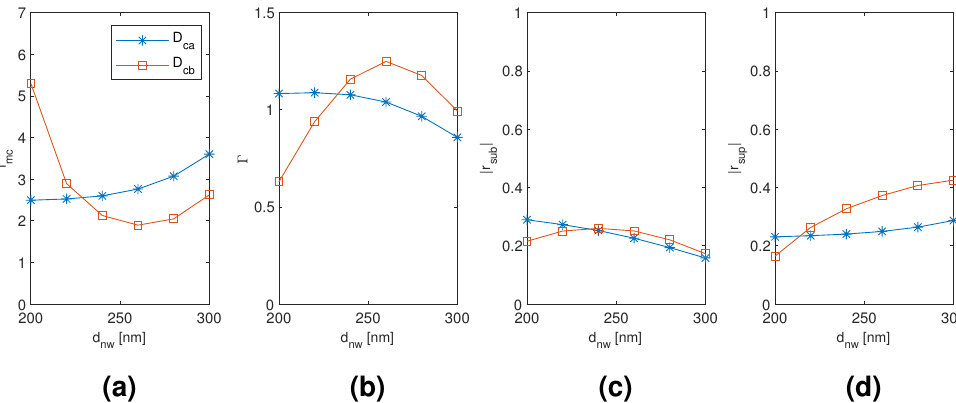
Figure 12. The results for the coated dimer D ca and D cb mode as a function of the diameter of the nanowires with the coating thickness and the separation of the nanowires corresponding to the point of modal cost function minimum for each mode (as listed in Table 2). ( a ) modal cost function value; ( b ) modal confinement factor; ( c ) substrate modal reflection coefficient magnitude; ( d ) superstrate modal reflection coefficient magnitude.